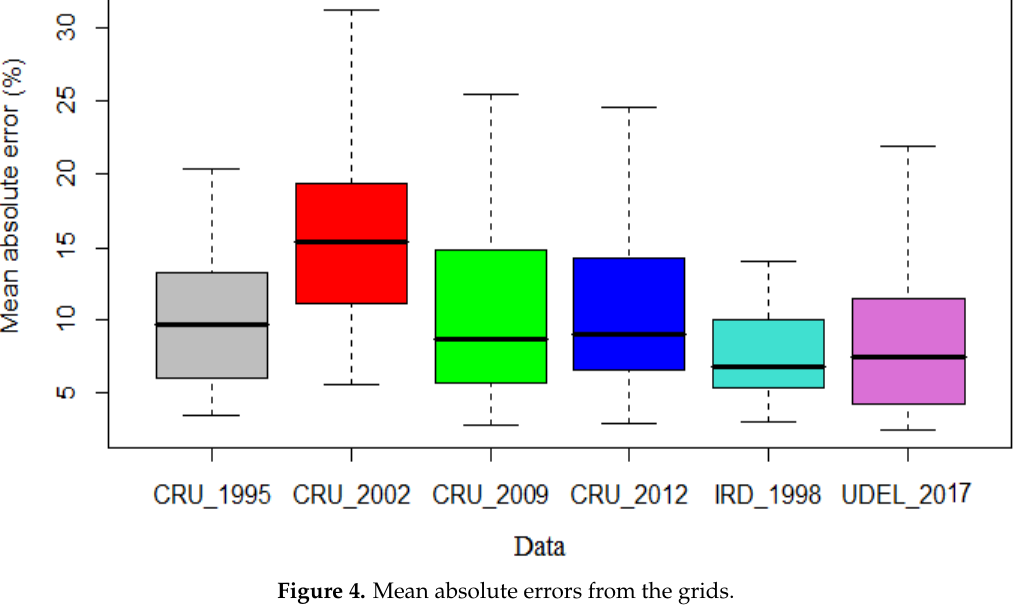
Figure 4. Mean absolute errors from the grids.